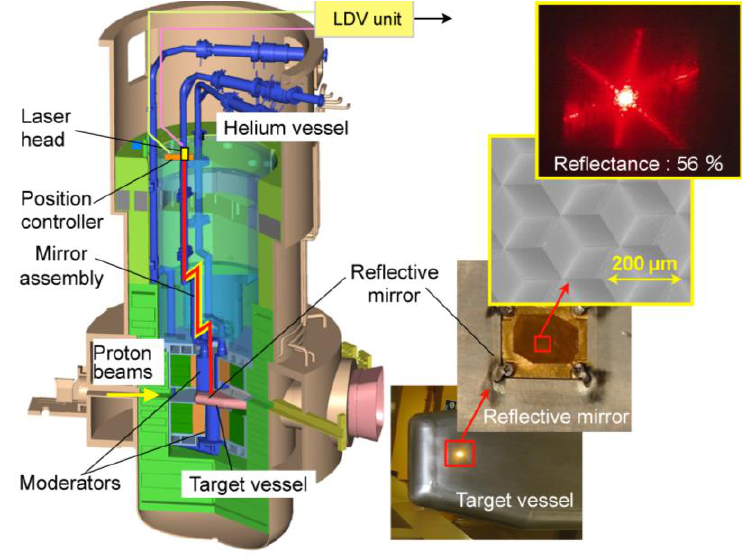
Figure 5. Target diagnostic system consists of the Laser Doppler vibrometer (LDV) installed in the helium vessel.